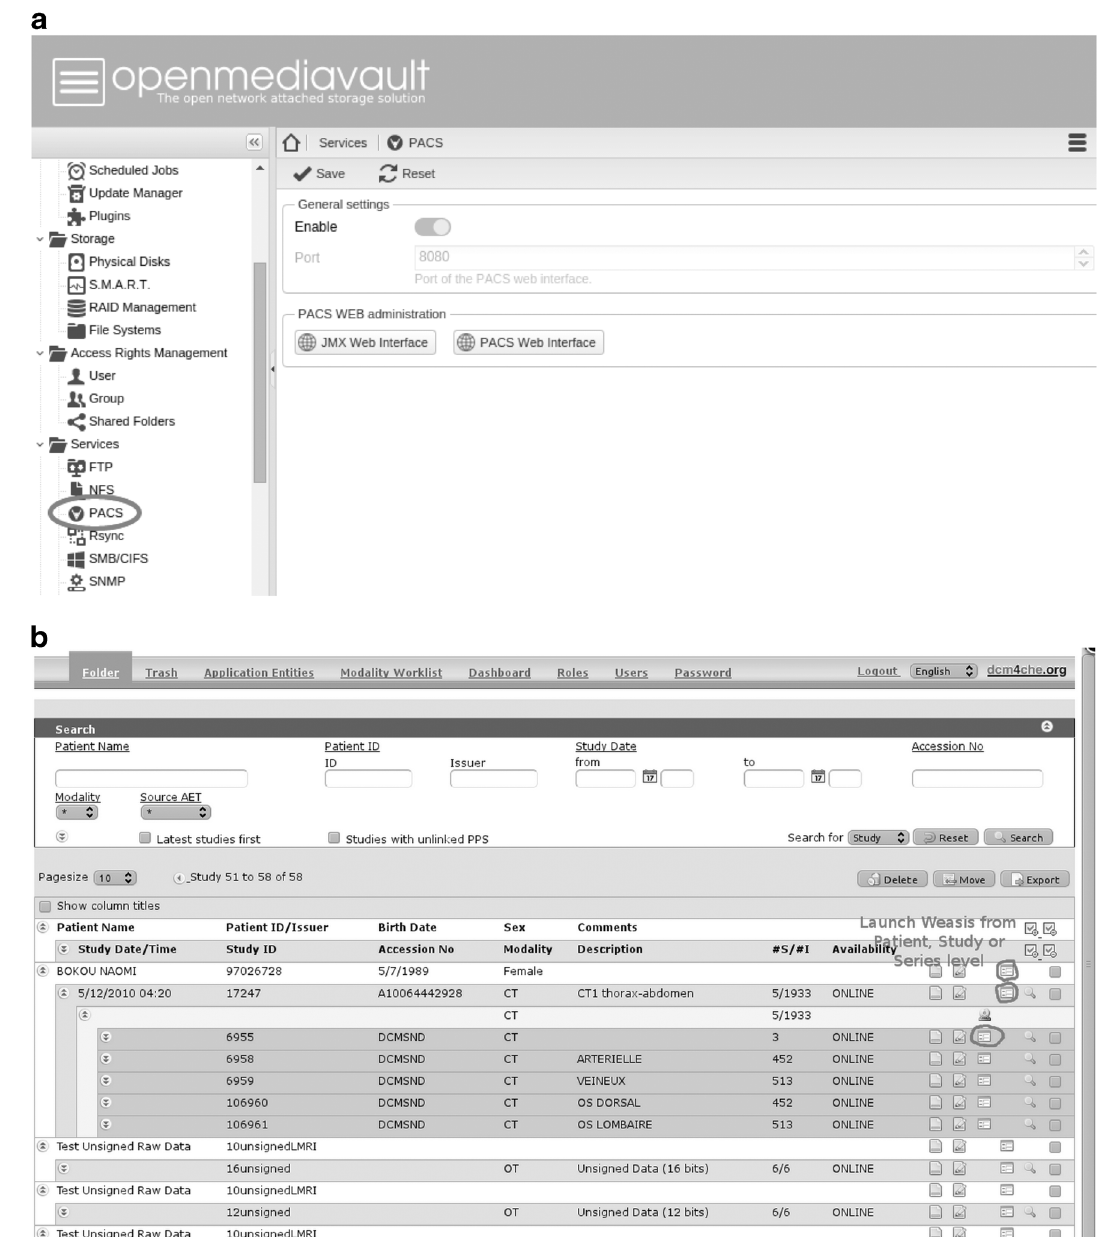
Fig. 4 a The main window of the B OpenMediaVault ^ software used for data management. This basic framework was extended with a specific B PACS ^ plugin designed for management of DICOM files and medical imaging data, b The management and basic maintenance functions of